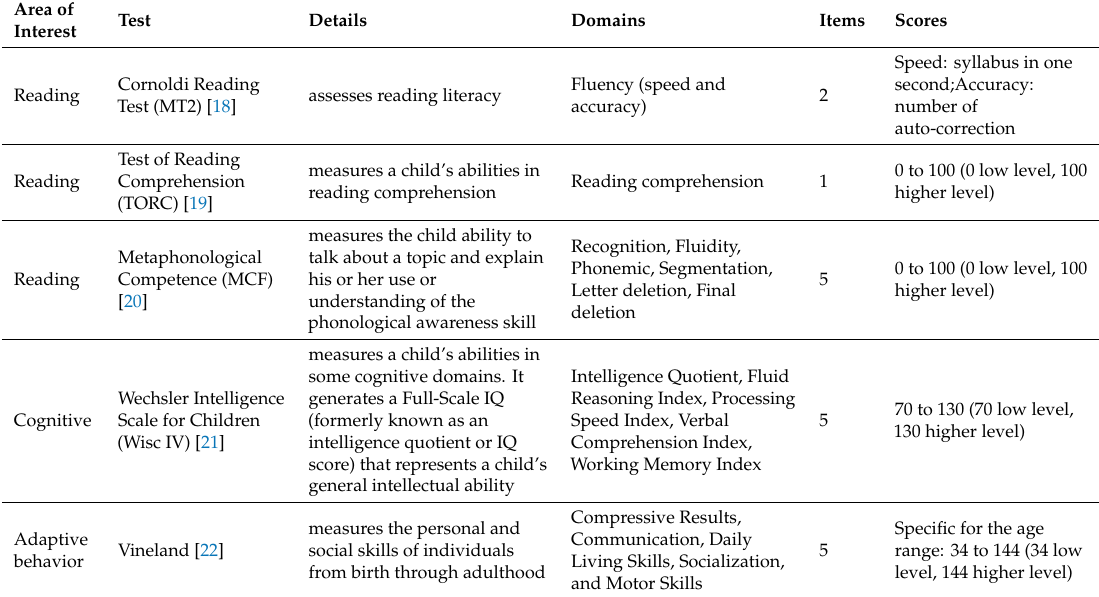
Table 2. Di ff erent tests administered to children by psychologist at T0 and T1.